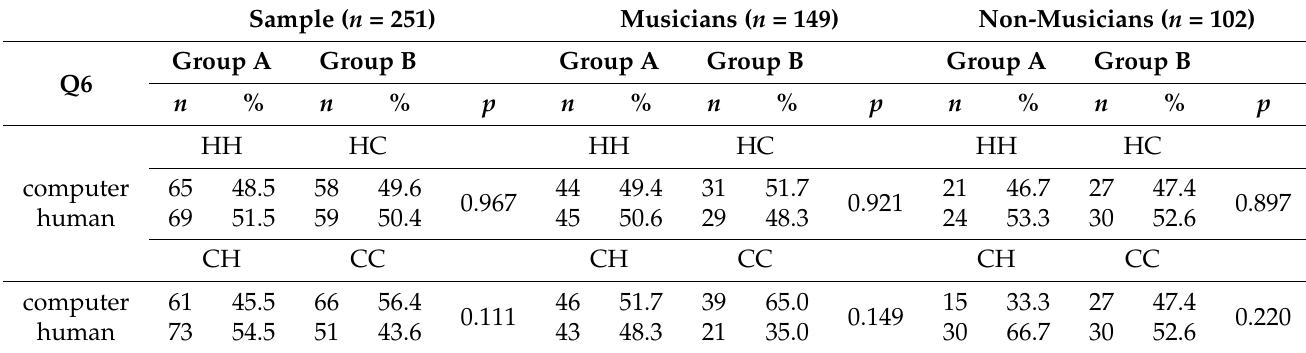
Table 8. Results of the explicit inquiry about the nature of the composer in Phase II of the experiment. Sample ( n = 251)